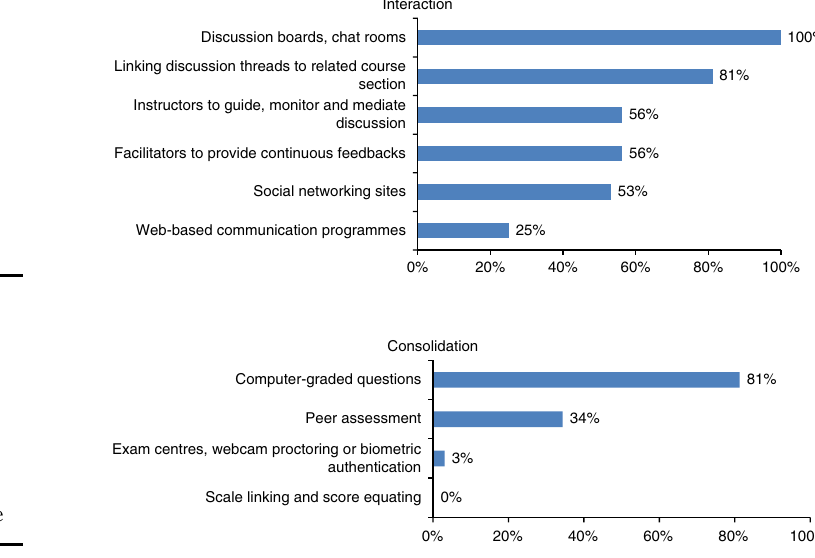
Figure 4. Presence of factors in the consolidation